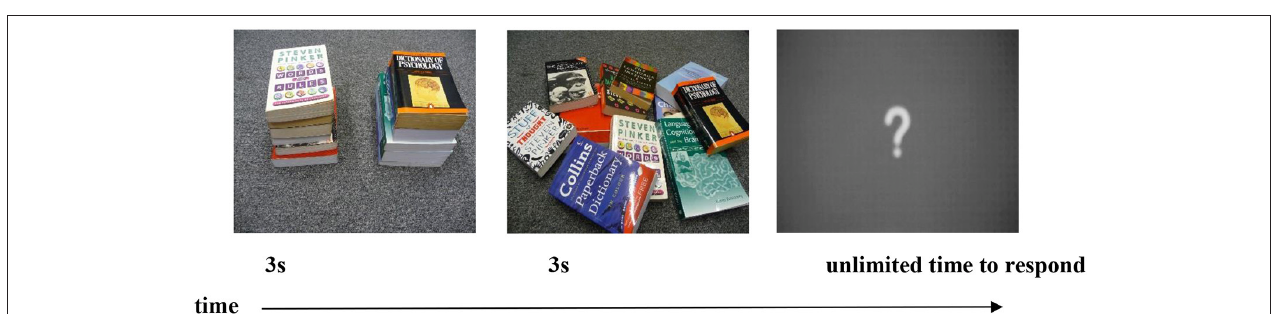
FIGURE 4 | Example of a distributive trial with a change in